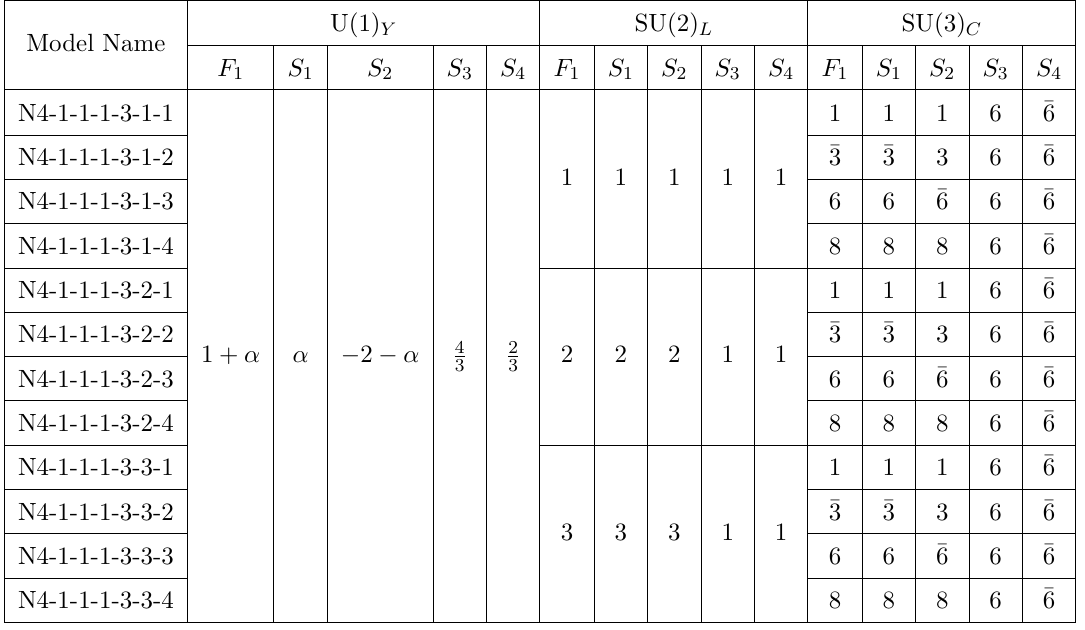
Table 8 . The one-loop models for the 0 νββ decay operator N4 arising from the diagram N4-1-1-1-3 shown in figure